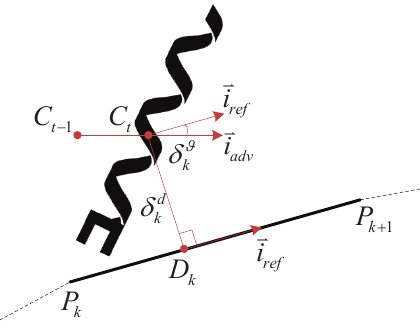
Figure 6. A schematic of linear segment path